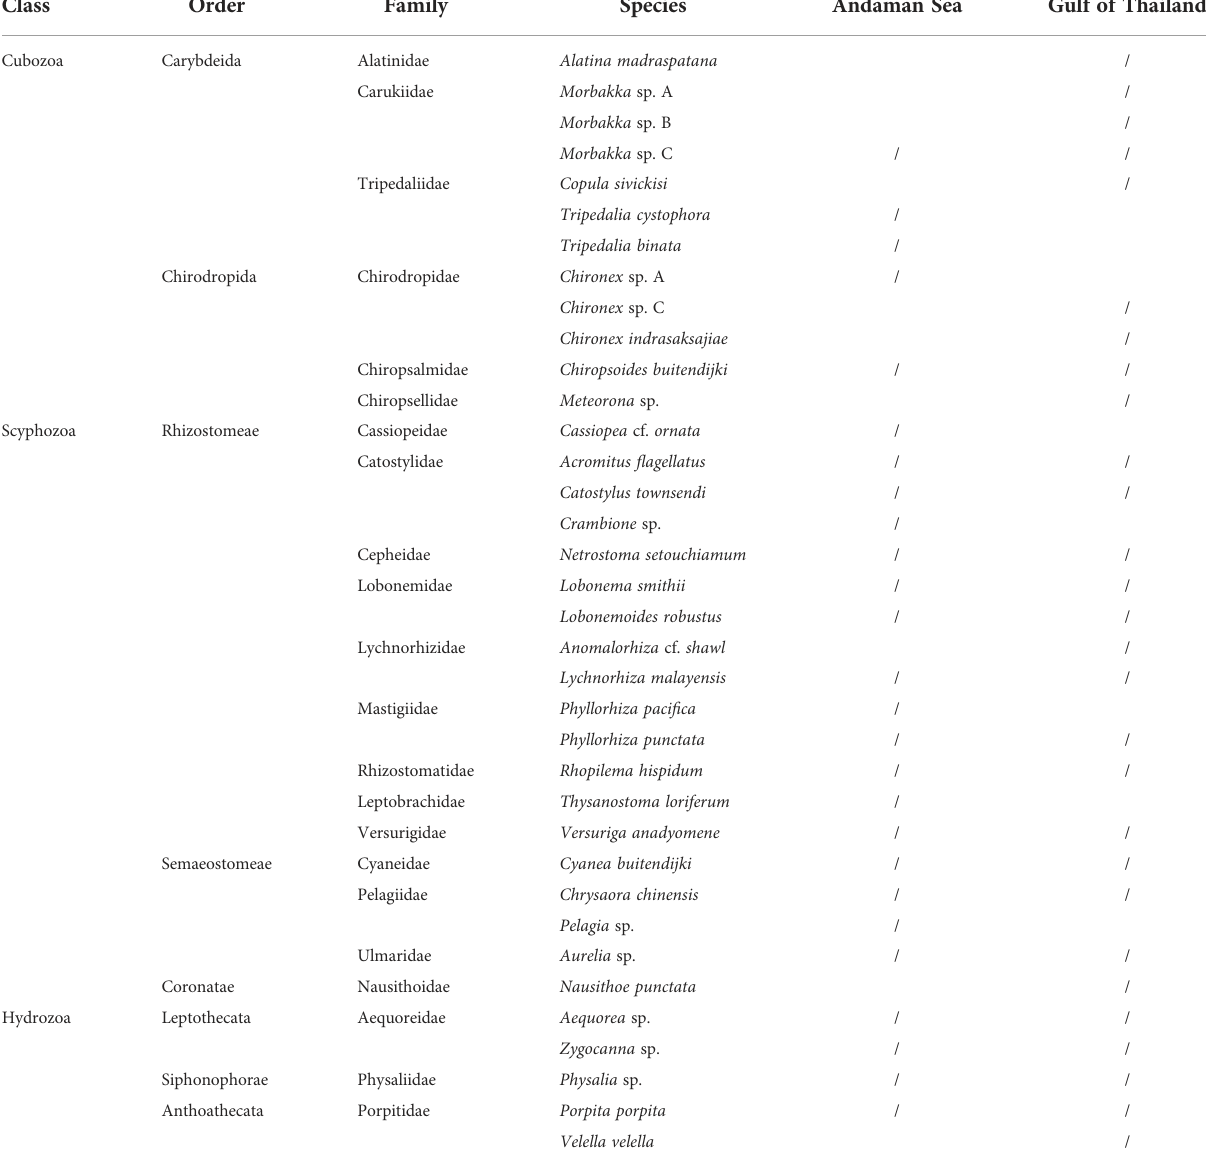
TABLE 1 List of venomous jelly fi sh found in Andaman Sea and Gulf of Thailand (data from Department of Marine and Coastal Resources).